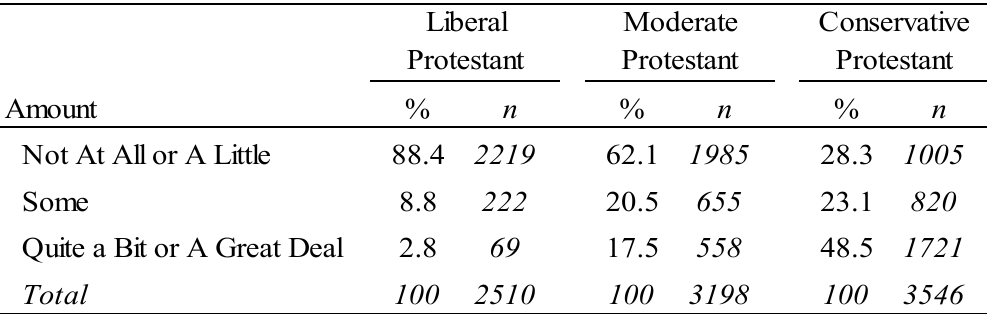
Table 1. Congregational Discourse on Abstaining from Alcohol.